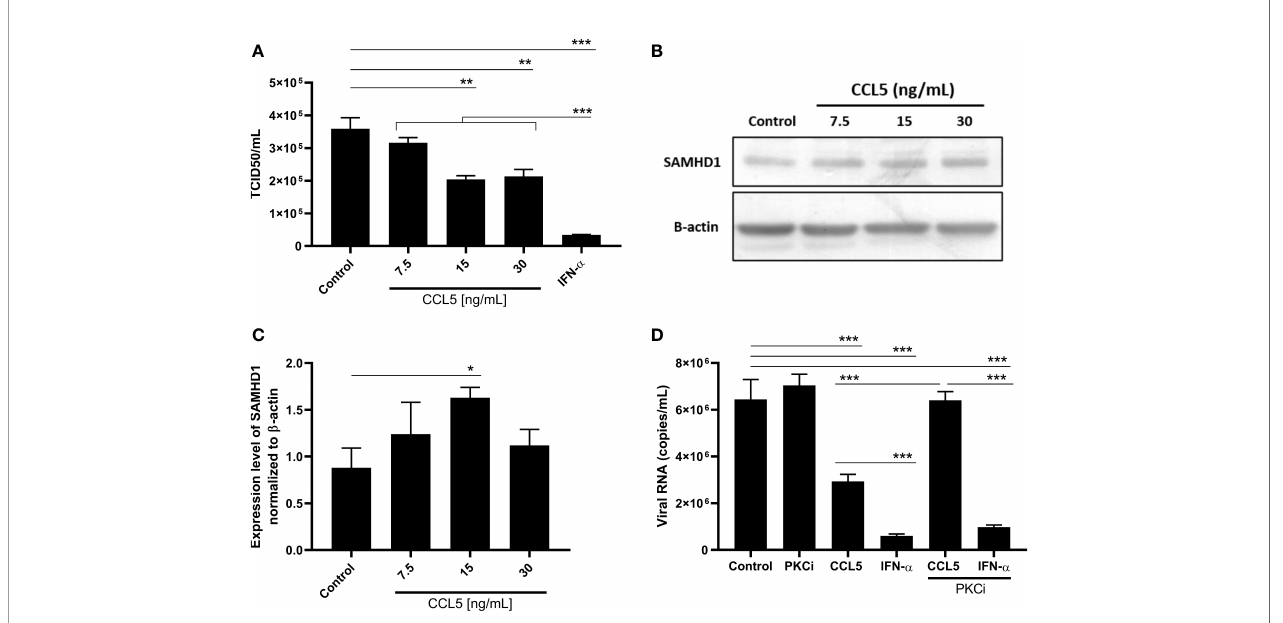
FIGURE 2 | CCL5 inhibits in fl uenza A replication and induces SAMHD1 protein expression. A549 cells were treated with different concentrations of CCL5 and, 24 hours later, were (A) infected with in fl uenza A at MOI 2 during 1h for viral replication analysis, or (B, C) lysed for SAMHD1 protein expression evaluation by western blot assay with b -actin as a housekeeping protein; bands were analyzed by densitometry using the ImageJ software 1.5.0, with (C) representing three blot assays. The basal levels of SAMHD1 protein are shown in A549 cells (control) exposed to medium only. (D) A549 cells were treated with CCL5 (15 ng/mL) in the presence or not of a PKC inhibitor (Go6983, 50 nM), and 24 hour later were infected with in fl uenza A at MOI 2 during 1 hour, for viral replication analysis. Viral titer was evaluated 24 hpi by TCID 50 assays. Data were obtained from 3 independent experiments with technical duplicates. *p < 0.05, **p < 0.01 and ***p <